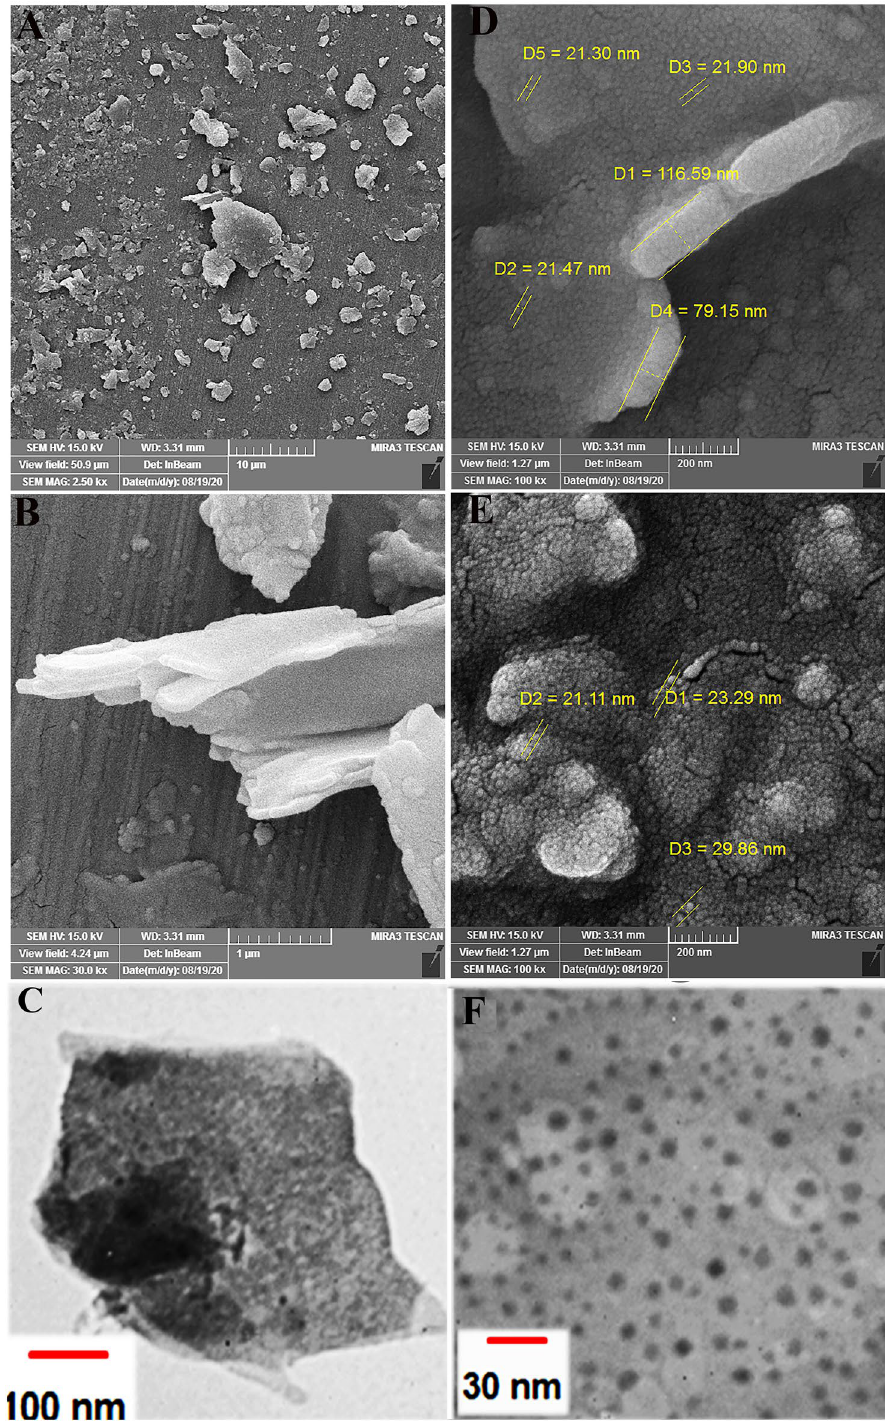
Figure 3. ( A , B ) FESEM images of malachite and ( D , E ) FESEM images of ZnO/Mlt-NC in different magnifications; ( C ) TEM image of malachite and ( F ) TEM image of